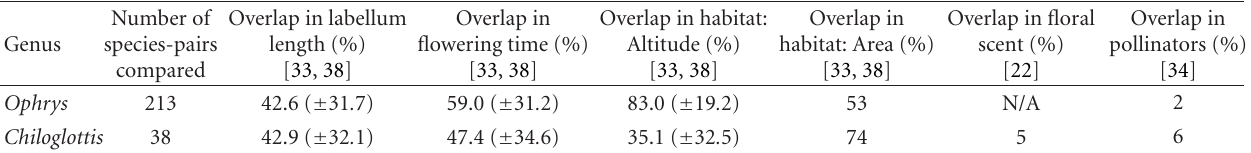
Table 1: Summary of comparisons of floral traits, distribution, and pollinators among closely related species pairs in Ophrys and Chiloglottis . Data on floral labellum, flowering time, and altitude range distribution are presented as mean ( ± standard deviation). Data on distribution, floral scent, and pollinators are presented as mean